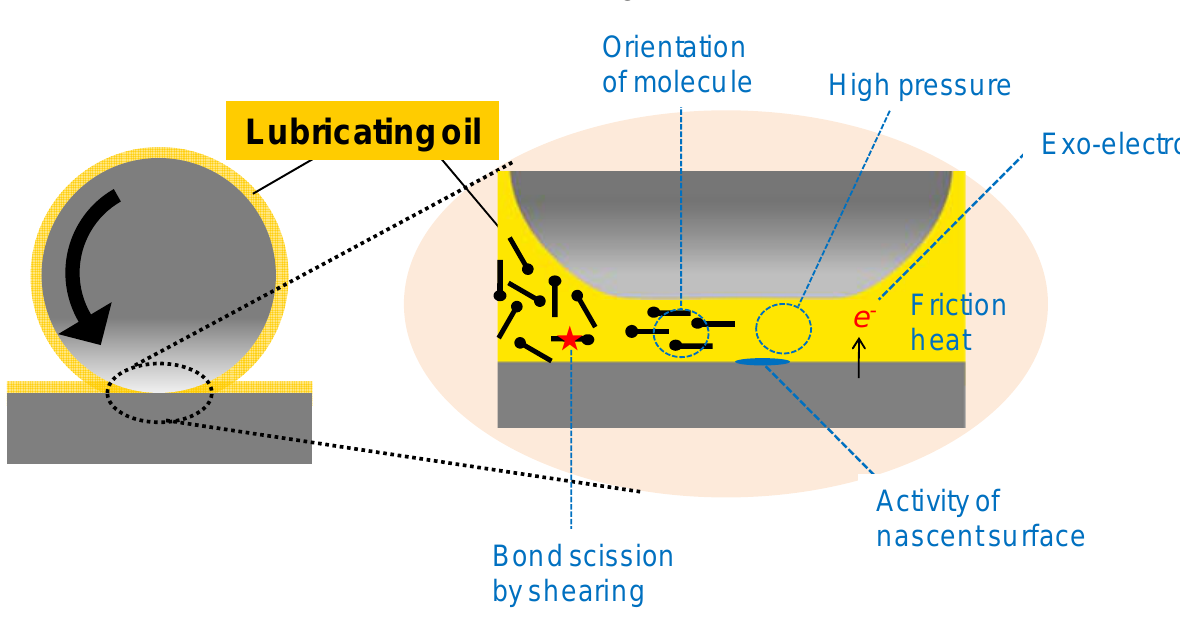
Figure 13. Model for rubbing surface as reaction